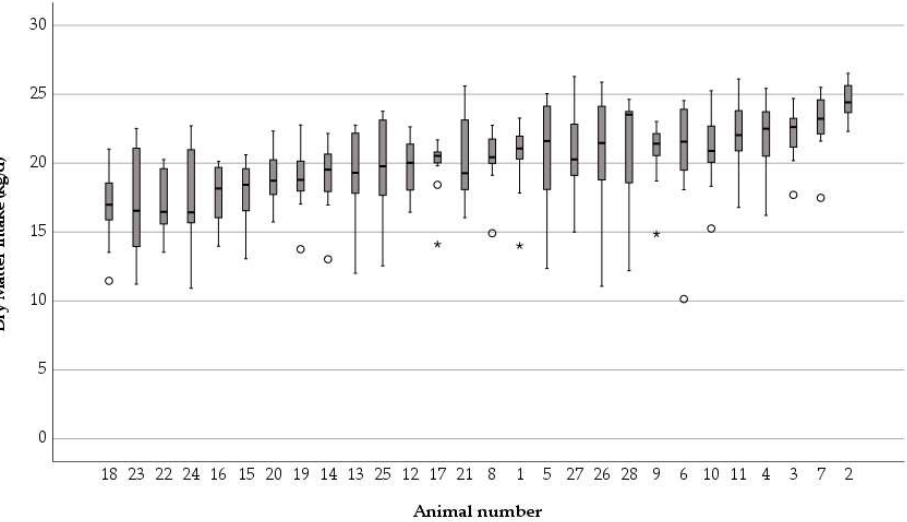
Figure 1. Dry matter intake (kg/day) measured between weeks 2 and 15 postpartum (p.p.). In each subfigure, the boxplots respectively highlight the median, upper, and lower quartiles of each week. Box whiskers extended to the most extreme nonoutlier data points above and below the box; data points were considered as outliers if they lay more than 1.5 times the interquartile range from the edge of the box. Small circles = outliers (1.5 × interquartile range (IQR)); asterisks = extreme values (3 × IQR).